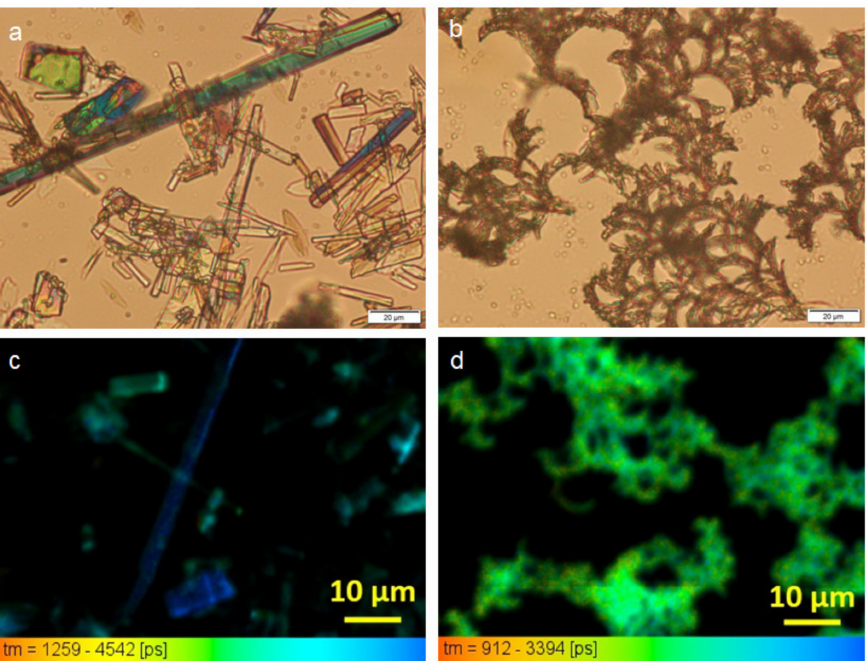
Figure 3. ( a )The POM image of only NDI 1 in DMF showing blue-green birefringence; ( b ) The POM image of NDI 1 and β -CD gel in DMF; ( c ) The FLIM image of only NDI 1 in DMF showing blue fluorescence; ( d ) The FILM image showing NDI 1 and β -CD gel in DMF showing greenish- blue